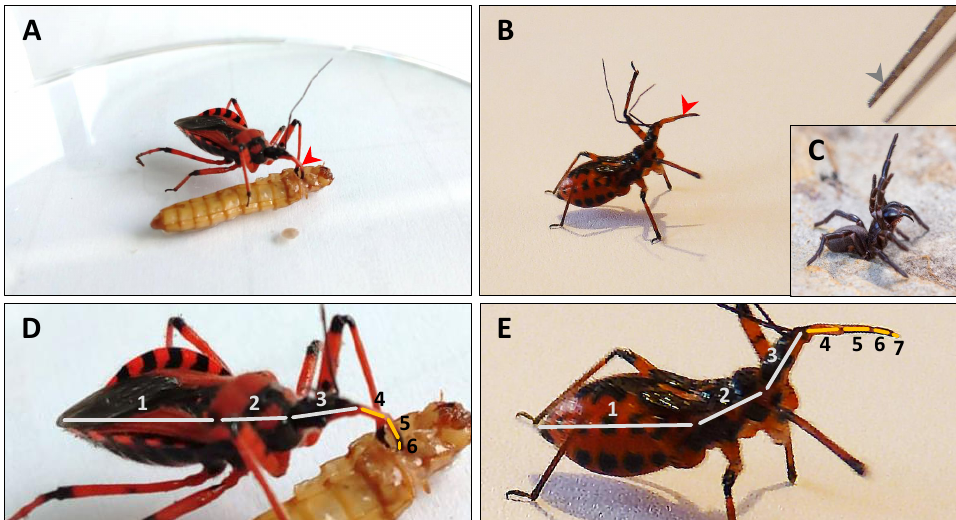
Figure 1. Rhynocoris iracundus using its proboscis for feeding or defense purposes. ( A ) R. iracundus using its proboscis (red arrowhead) to feed on a Tenebrio molitor larva. The front legs are used to grab and hold its prey. ( B ) R. iracundus in defense position with its elevated front legs and long proboscis (red arrowhead), ready to attack entomological forceps (gray arrowhead). ( C ) Defense position of a Blue Mountains funnel-web spider Hadronyche versuta with elevated front legs and chelicerae (Photo credits: with permission of Greg Bourke). ( D , E ) Alignment of main body and proboscis segments during feeding and defense, respectively. Body segments are shown with gray lines: abdomen (1), thorax (2), head (3), and proboscis segments are displayed as yellow lines